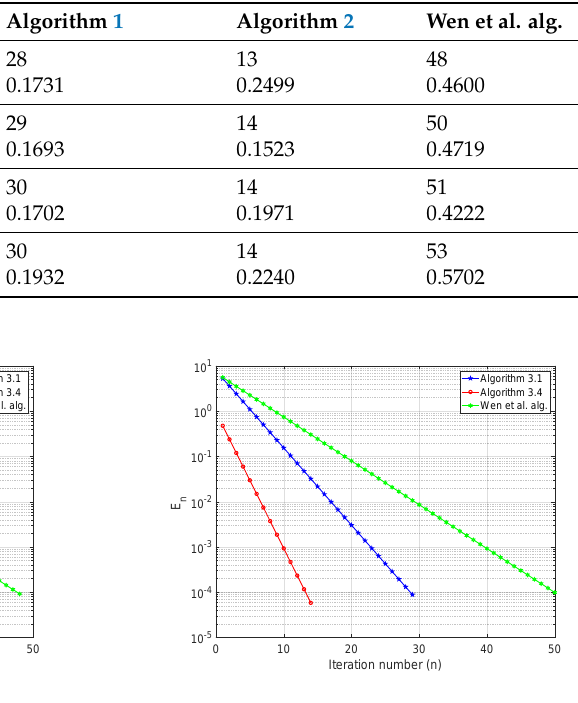
Algorithm 3.1 Algorithm 3.4 Wen et al. alg.